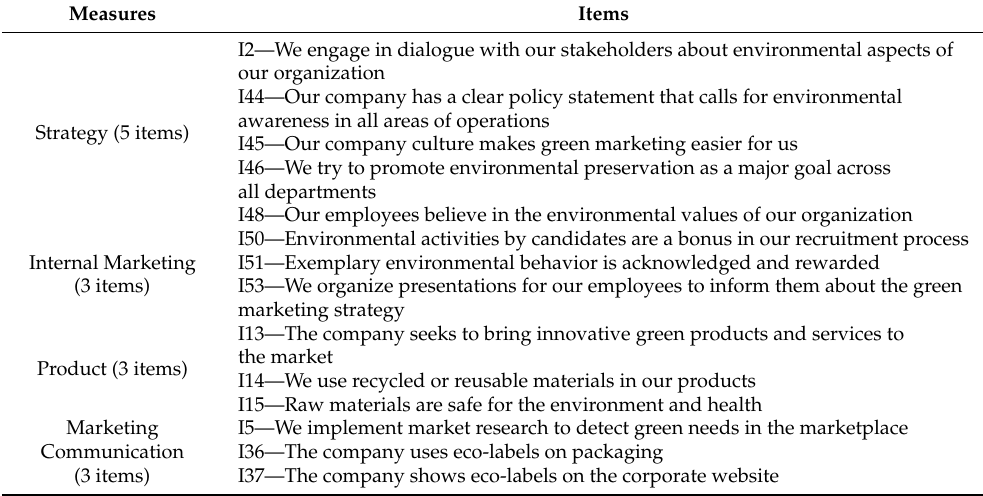
Table 5. The items in the Green Marketing Scale (GMaS).